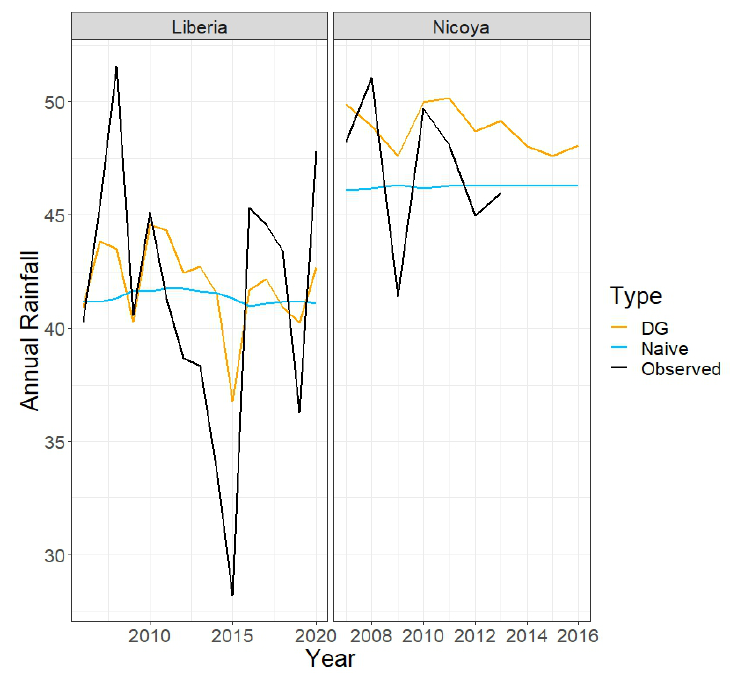
Figure 5. Predicted (using the double Gaussian and naive approaches) and observed total annual rainfall values at the Liberia station ( left ) from 2006 to 2020 and at the Nicoya station ( right ) from 2007 to 2016. Rainfall is reported on the scale log ( Y it ) + 1.